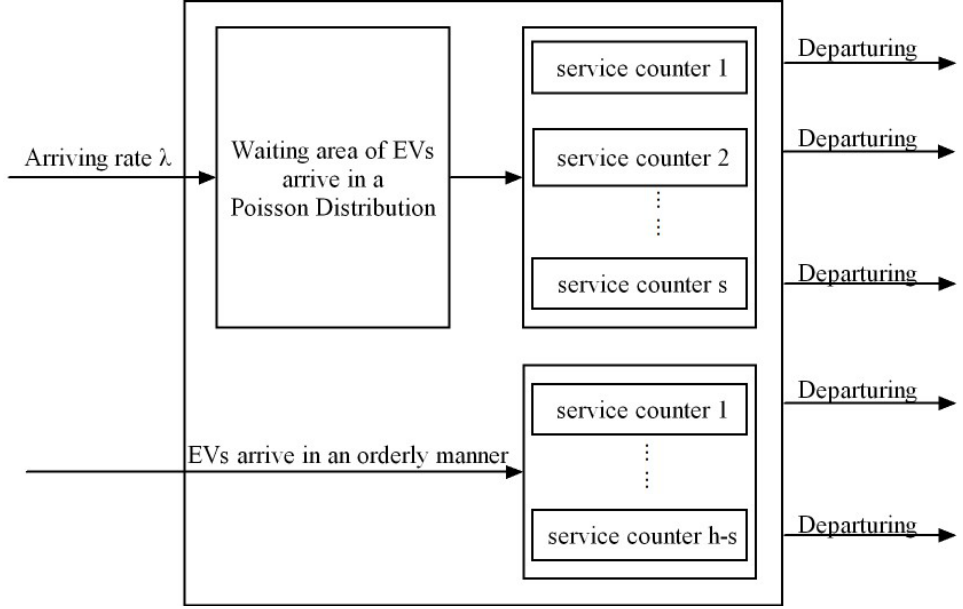
Figure 2. The queuing system of EVCS.